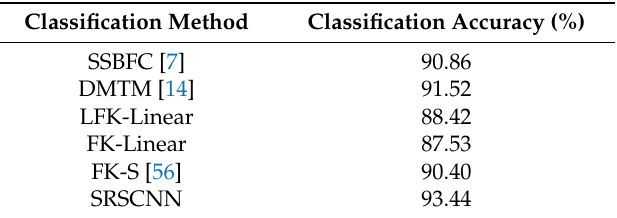
Table 4. Comparison between the published accuracies with the Google dataset of SIRI-WHU, with 50% training samples